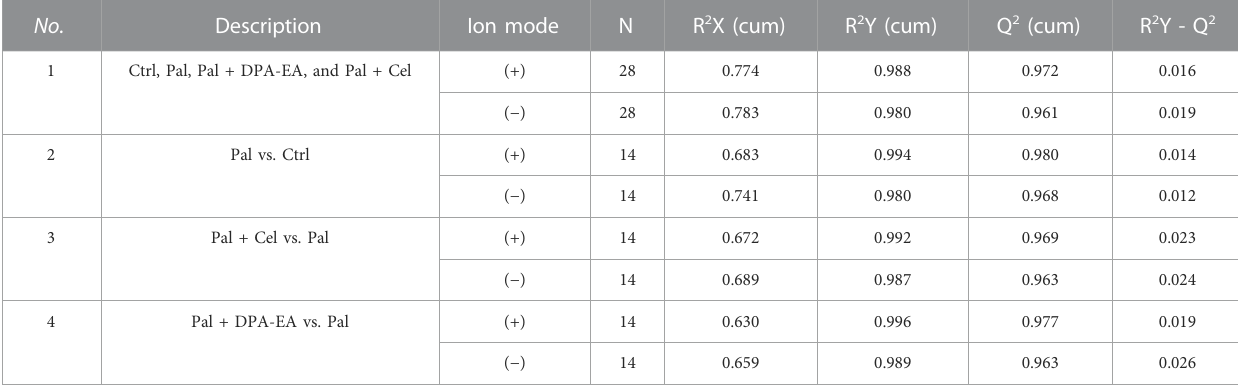
TABLE 1 Corresponding values of R 2 X, R 2 Y, and Q 2 of OPLS-DA models. No.